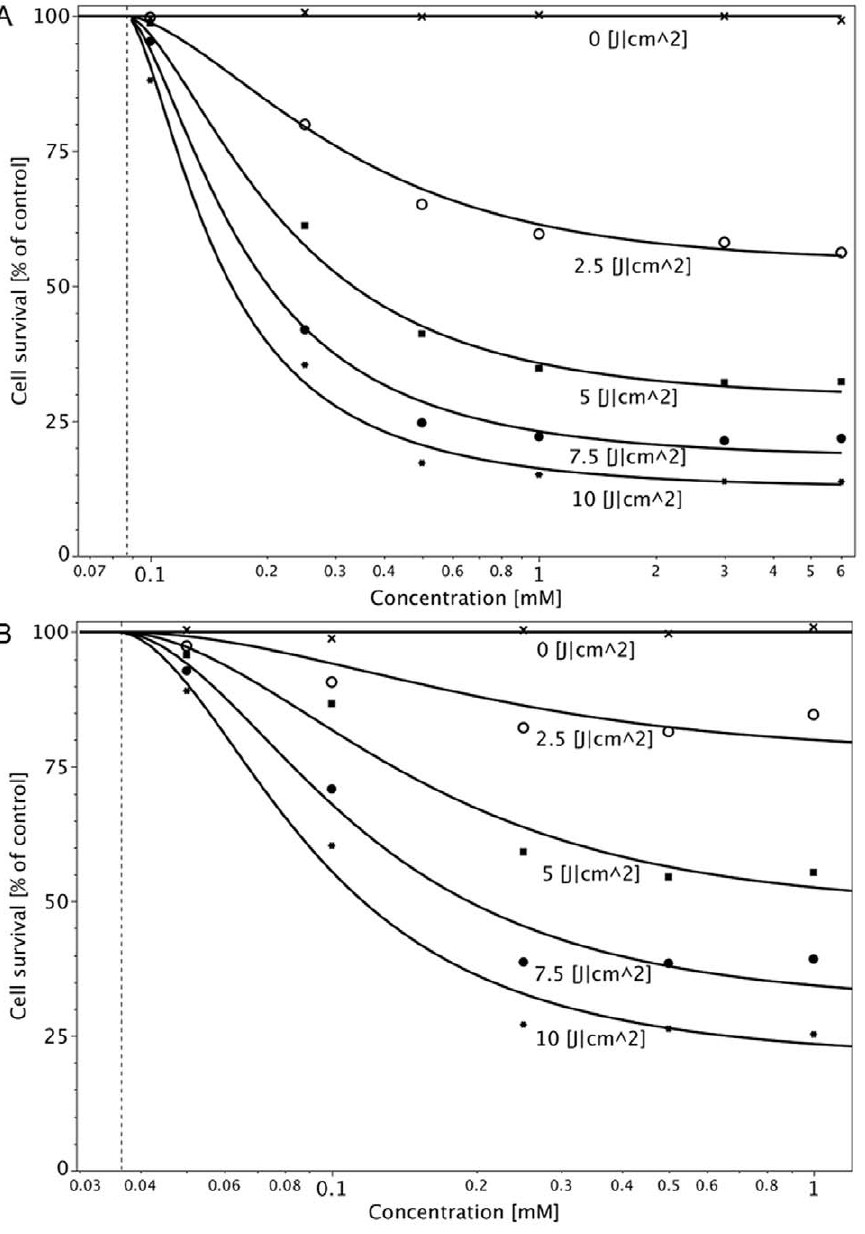
Figure 6. Photocytotoxicity of 5-ALA-derived PpIX in D283 Med (A) and U373 MG cells (B). Concentration- and fluence-dependent N photocytotoxicity is demonstrated after incubation with 5-ALA for 2 h. Illumination was performed at 635 nm, and light was delivered at 20 mW/cm 2 at doses of (x) 0, (o) 2.5, ( & ) 5, ( ) 7.5, (*) and 10 J/cm 2 . Cell survival was measured by NR assay 48 h after illumination. Cell survival was calculated per Formula (4). Dashed line shows D 0 . (For the two cell lines the R 2 values are 99.7% (D283 Med) and 98.7% (U373 MG), respectively.) (cid:7) The relationship between cell survival S LD ð Þ [%] and light is defined as the light dose needed to inactivate J ] for HYP PDT was expressed by: dose LD [ cm 2 50% of living cells (lethal light dose 50). Values of quantitative data are given as median (central tendency) + / 2 median absolute deviation (MAD, variability) except otherwise noted.